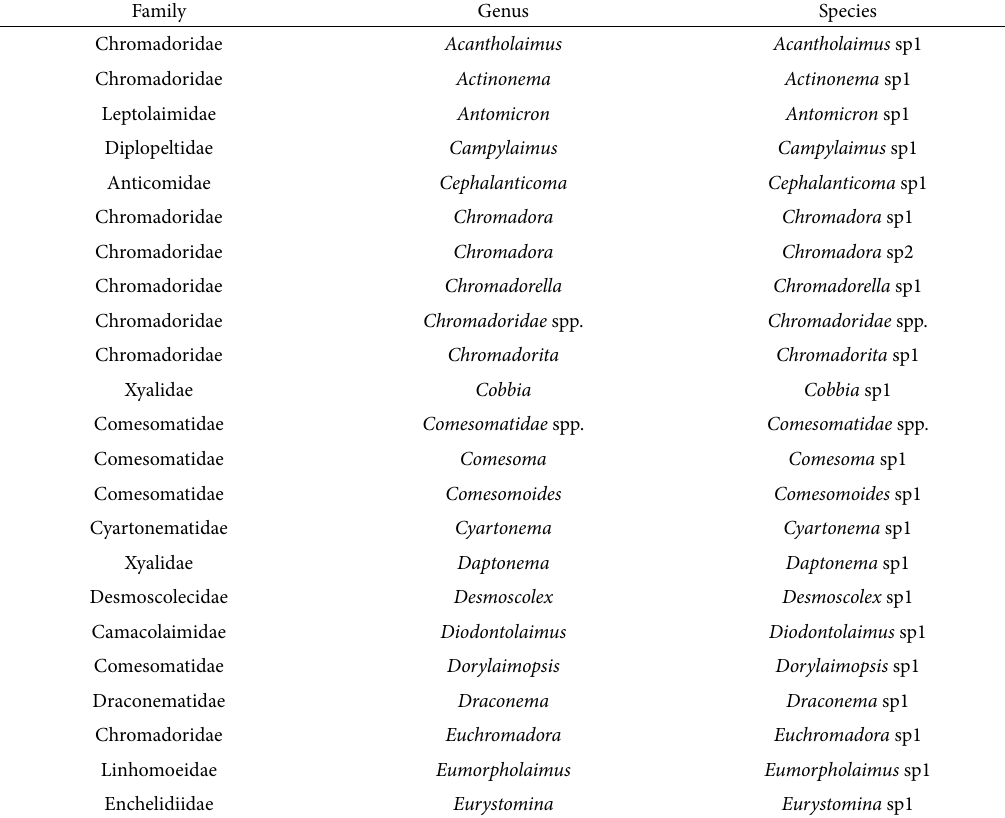
Table S3. – List of nematode families, genera and putative species found in the maerl